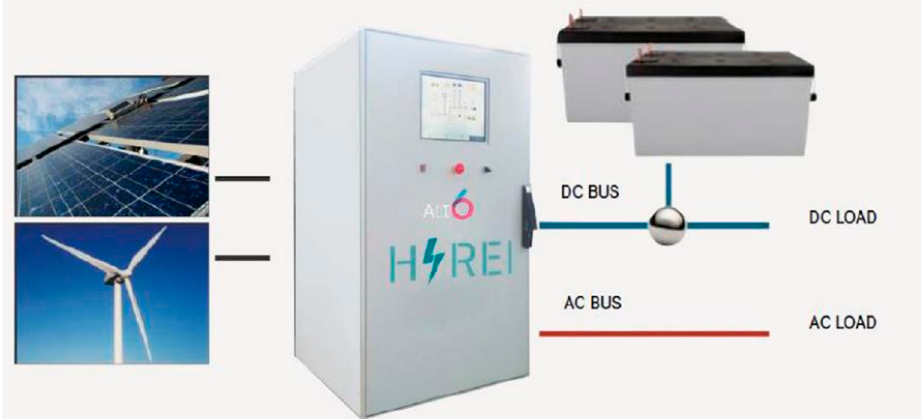
Figure 2. Typical structure for hybrid uses of the equipment.